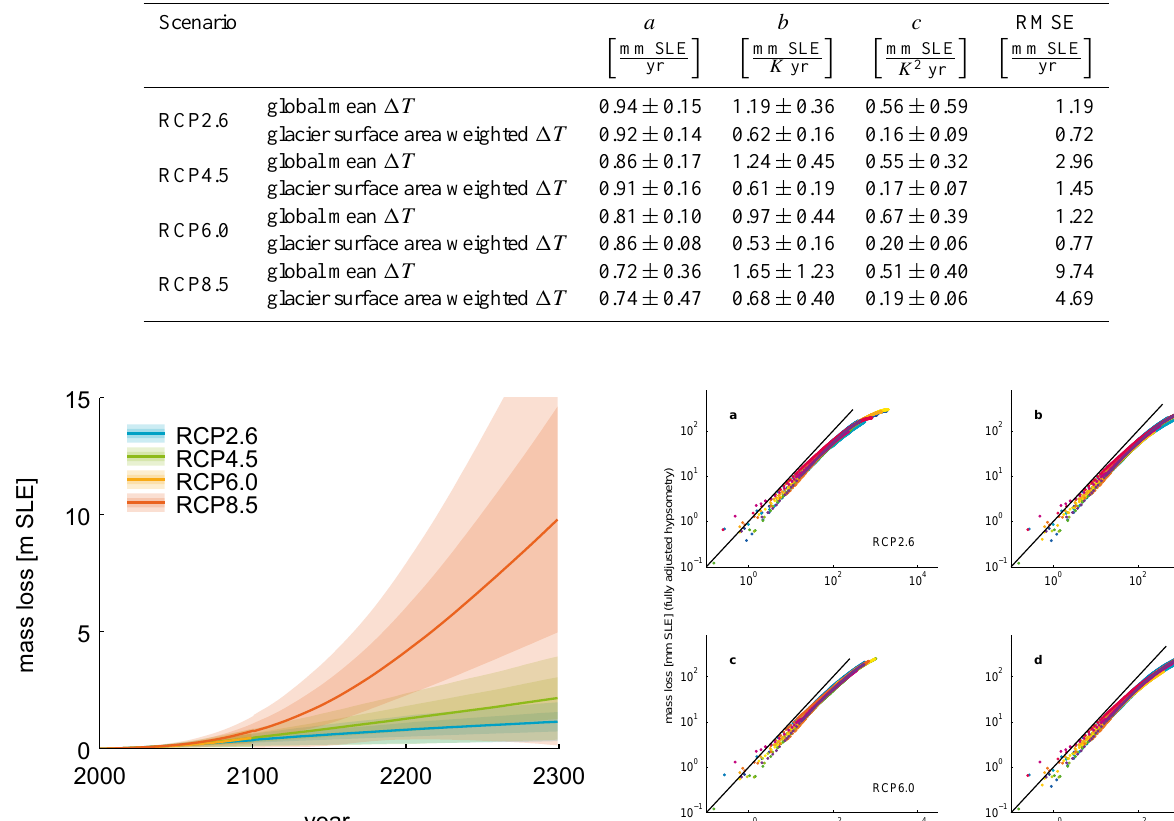
fitted to the modeled global glacier mass balance 1T |